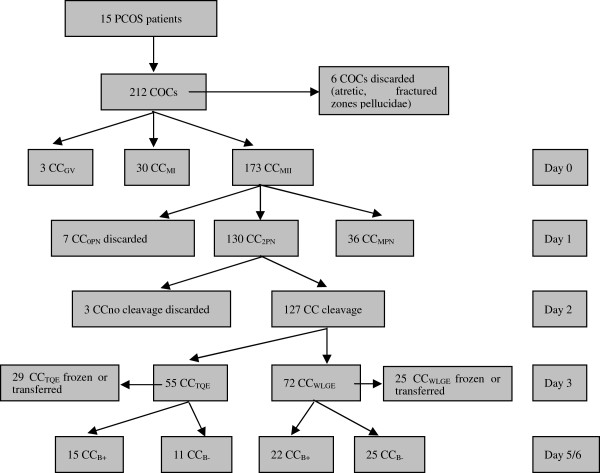
Distribution tree of COCs involved in the study. A total of 212 COCs were retrieved from the 15 PCOS patients. Except for 6 COCs which are atretic or with fractured zones pellucidae were discarded, there have 3 GV stage COCs, 30 MI stage COCs, and 173 MII stage COCs. On Day 1 (16–18 hours after insemination), 130 CCs separated from oocytes with normal fertilization (2PN) and 36 CCs separated from mature oocytes with abnormal fertilization (MPN) were classed into a “CC2PN” and “CCMPN” group, respectively. On Day 3, 54 of 127 embryos that developed from oocytes with normal fertilization (2PN) were transplanted or frozen, and their corresponding CCs were classified into six subgroups randomly. The other 73 embryos were cultured to the blastocyst stage. Cumulus cells from oocytes yielding blastulas after 5/6 days in vitro culture were classified as the “CCB+” group (n = 37), and cumulus cells from oocytes that stopped developing at the embryo stage after Day 6 were divided into “CCB-” groups (n = 36). COC, cumulus-oocyte-complex; CCGV, cumulus cells from GV oocyte; CCMI, cumulus cells from MI oocyte; CCMII, cumulus cells from MII oocyte; CC0PN, cumulus cells from oocyte which formed no pronuclei (0PN) after fertilization; CC2PN, cumulus cells from oocyte which formed two pronuclei (2PN) after fertilization; CCMPN, cumulus cells from oocyte which formed multi pronuclei (MPN) after fertilization; CCWLGE, cumulus cells from oocyte yielding a weak or low grade embryo at Day3; CCTQE, cumulus cells from oocyte yielding a top quality embryo at Day 3; CCB-, cumulus cells from oocyte which stopped development at the embryo stage at Day 5/6; CCB+, cumulus cells from oocyte yielding a blastocyst after 5/6 days of in vitro culture.